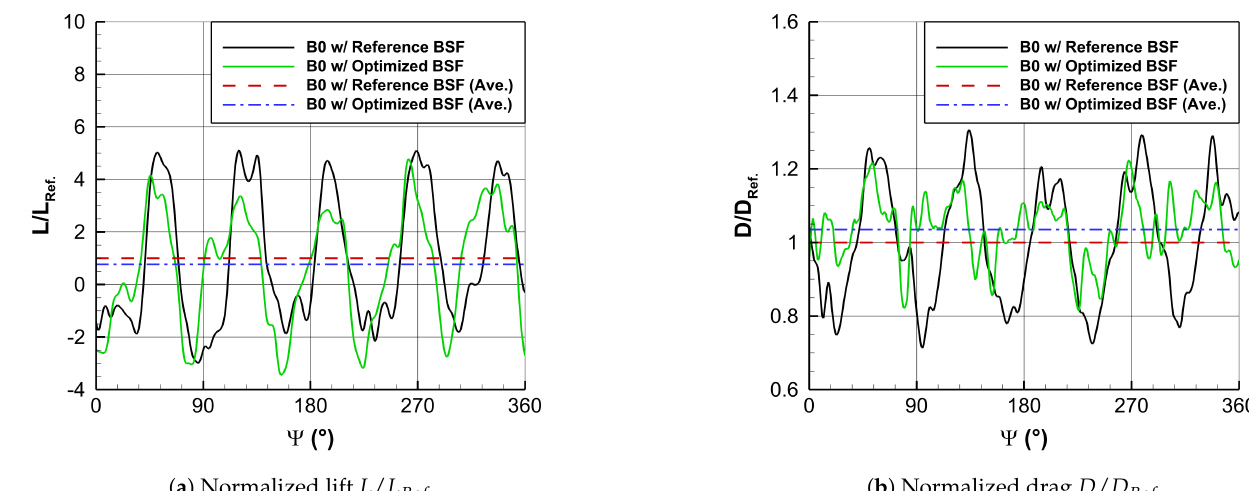
Figure 14. Comparison of the normalized aerodynamic forces for the FFB in combination with the optimized and the reference BSF for a single rotor